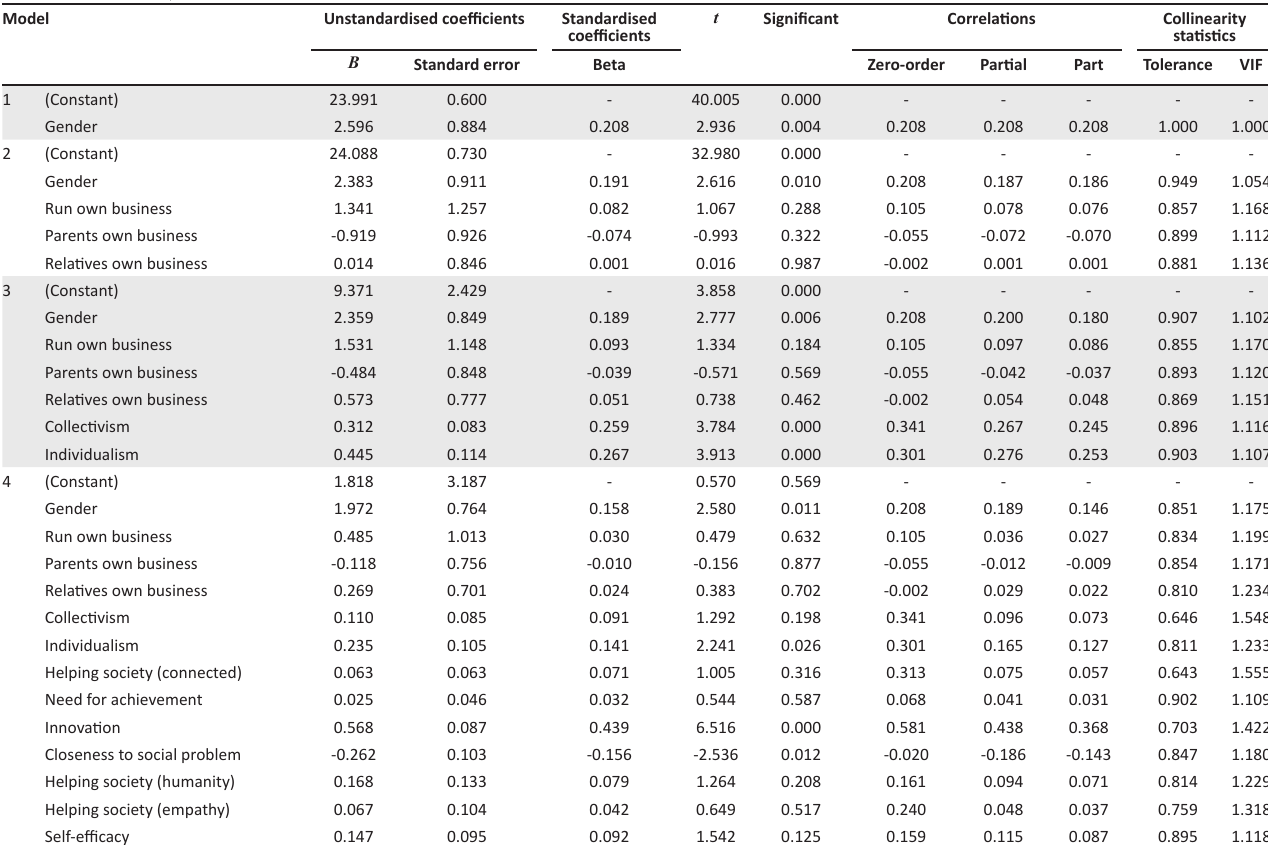
TABLE 4: Coefficients. † Model Unstandardised